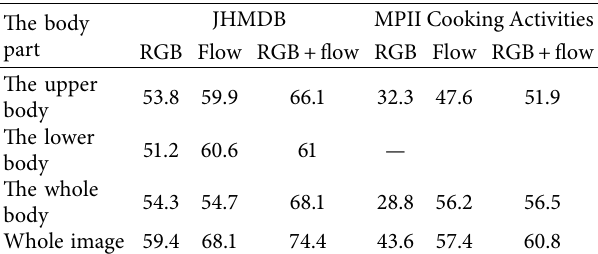
Table 1: Comparison of recognition effects of p-CNN feature